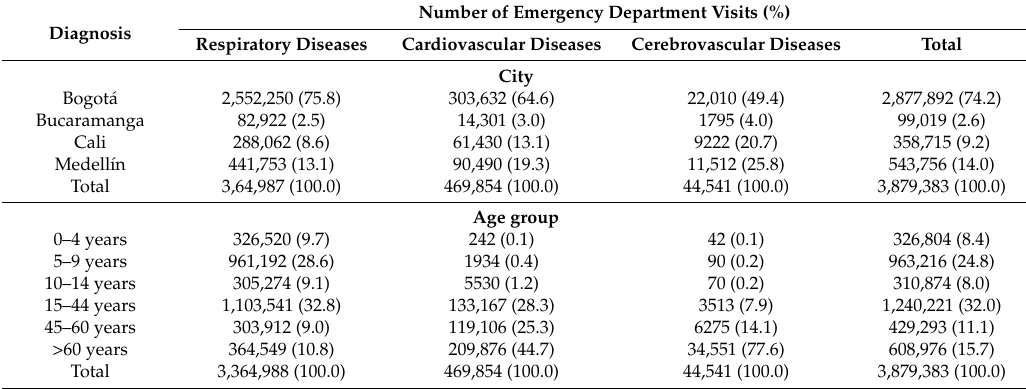
Table 1. Emergency department visits for respiratory, cardiovascular, and cerebrovascular diseases, by city and age group in Colombia,